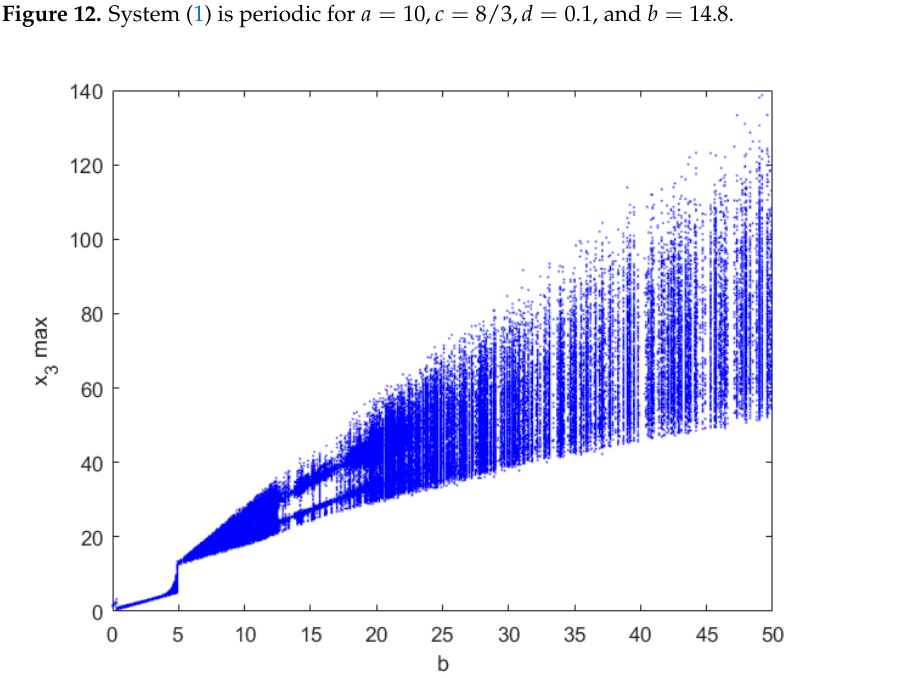
Figure 13. Bifurcation diagram for b ∈ [ 0,50 ] .